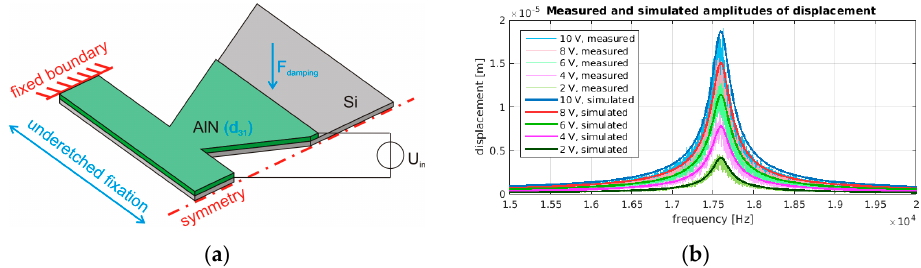
Figure 3. ( a ) Schematic view of the simulation model: The device is fixed at the left side and a symmetry boundary condition is applied at the right side. By applying an electrical field the AlN layer is strained in in-plane direction, which results in an out-of-plane bending of the flapper. The model parameters displayed in blue font are calibrated using LDV measurements; ( b ) Measurements and simulations of the frequency response of an exemplary twin-fin flapper, applying damping forces extracted from measurements, depending on the input